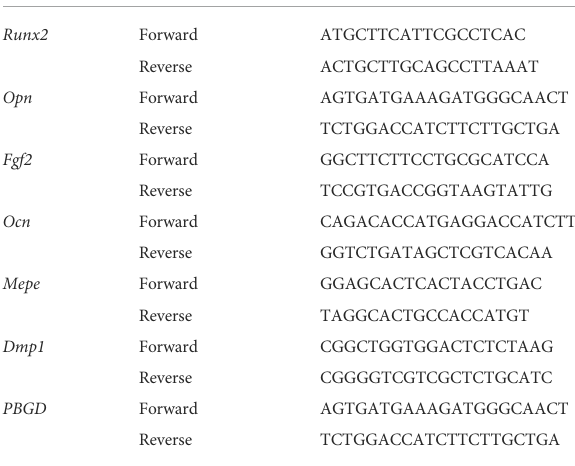
TABLE 1 Primer sequences used for real-time PCR. Target gene Primer